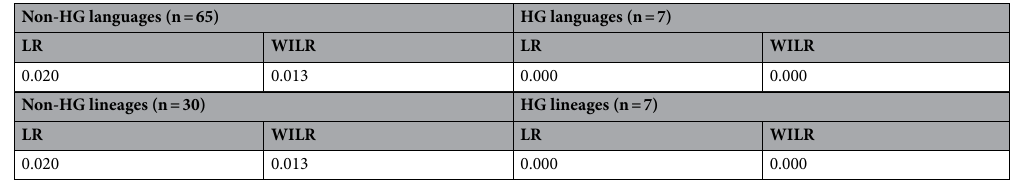
Table 3. Average LR and WILR values for 72 JIPA texts, by language and by language